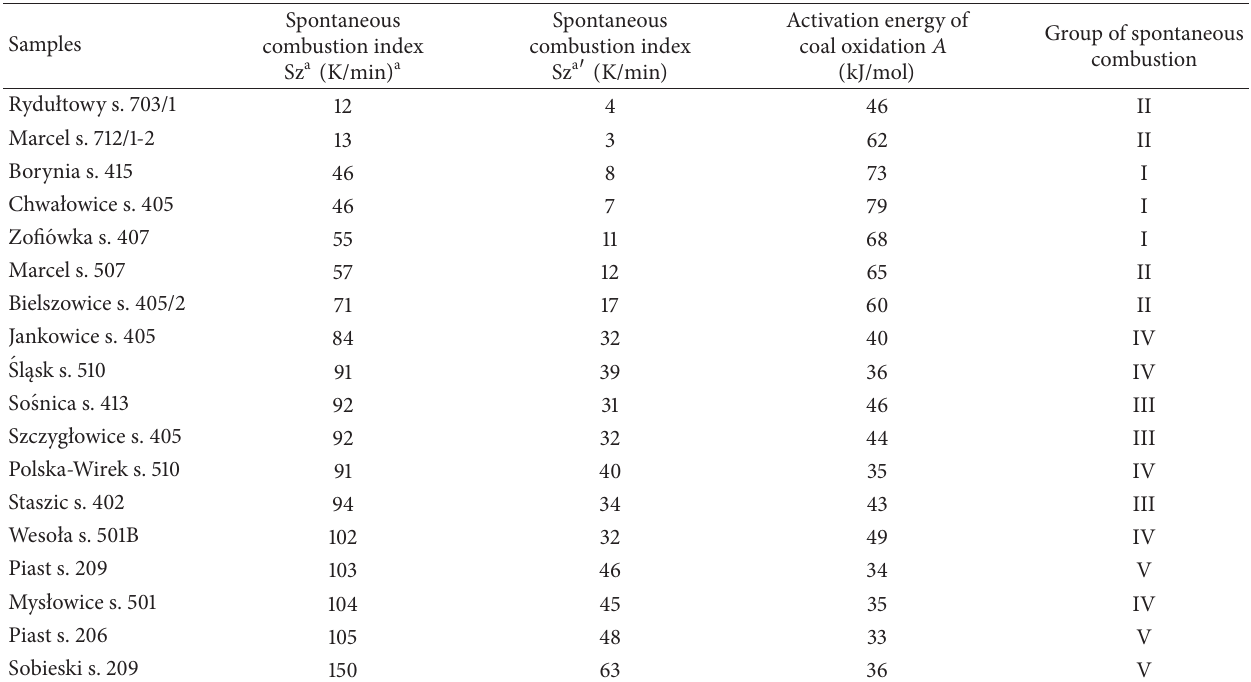
Table 2: The values of spontaneous combustion indexes and the activation energy for individual coal samples with the corresponding group of spontaneous